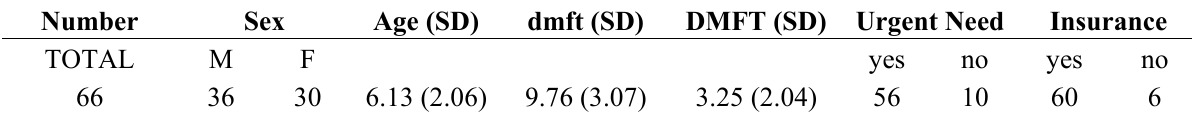
Table 1. Characteristics of patients who received dental care under general anesthesia.